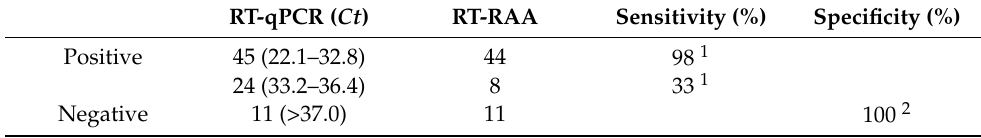
Table 2. Comparison between RT-RAA and RT-qPCR for detection of clinical